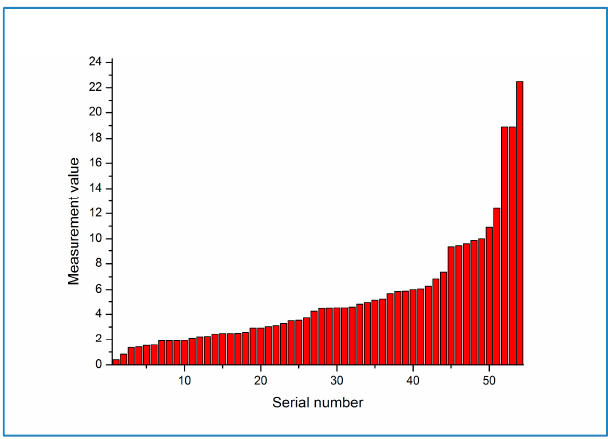
Figure 7. The size composition of the app in the test set.